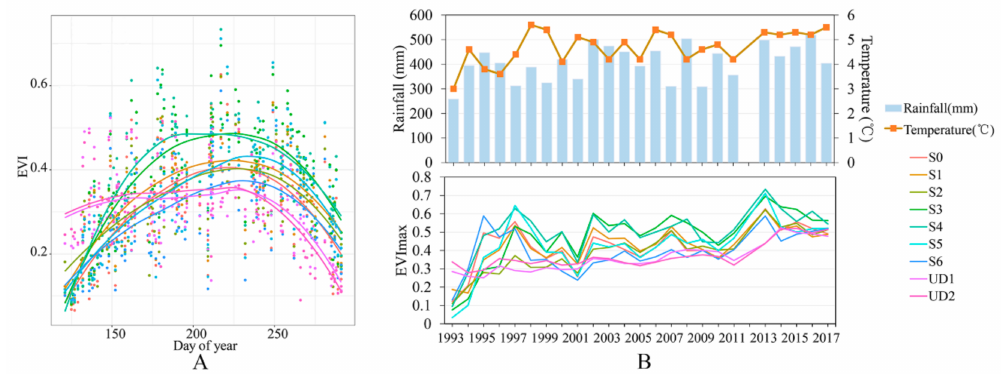
Figure 2. ( A ) MODIS enhanced vegetation index (EVI) variation with day of year over field plots; ( B ) annual maximal MODIS EVI over field plots, and average annual temperature and annual rainfall from meteorological stations.